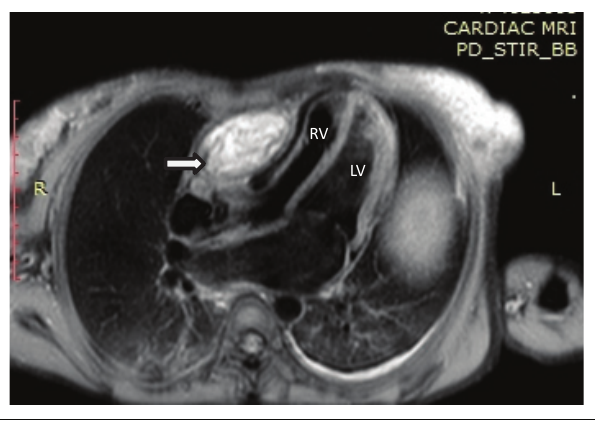
FIGURE 3: Proton density (4-chamber view) shows a predominantly hyperintense lesion with mass effect, as indicated by the white arrow.